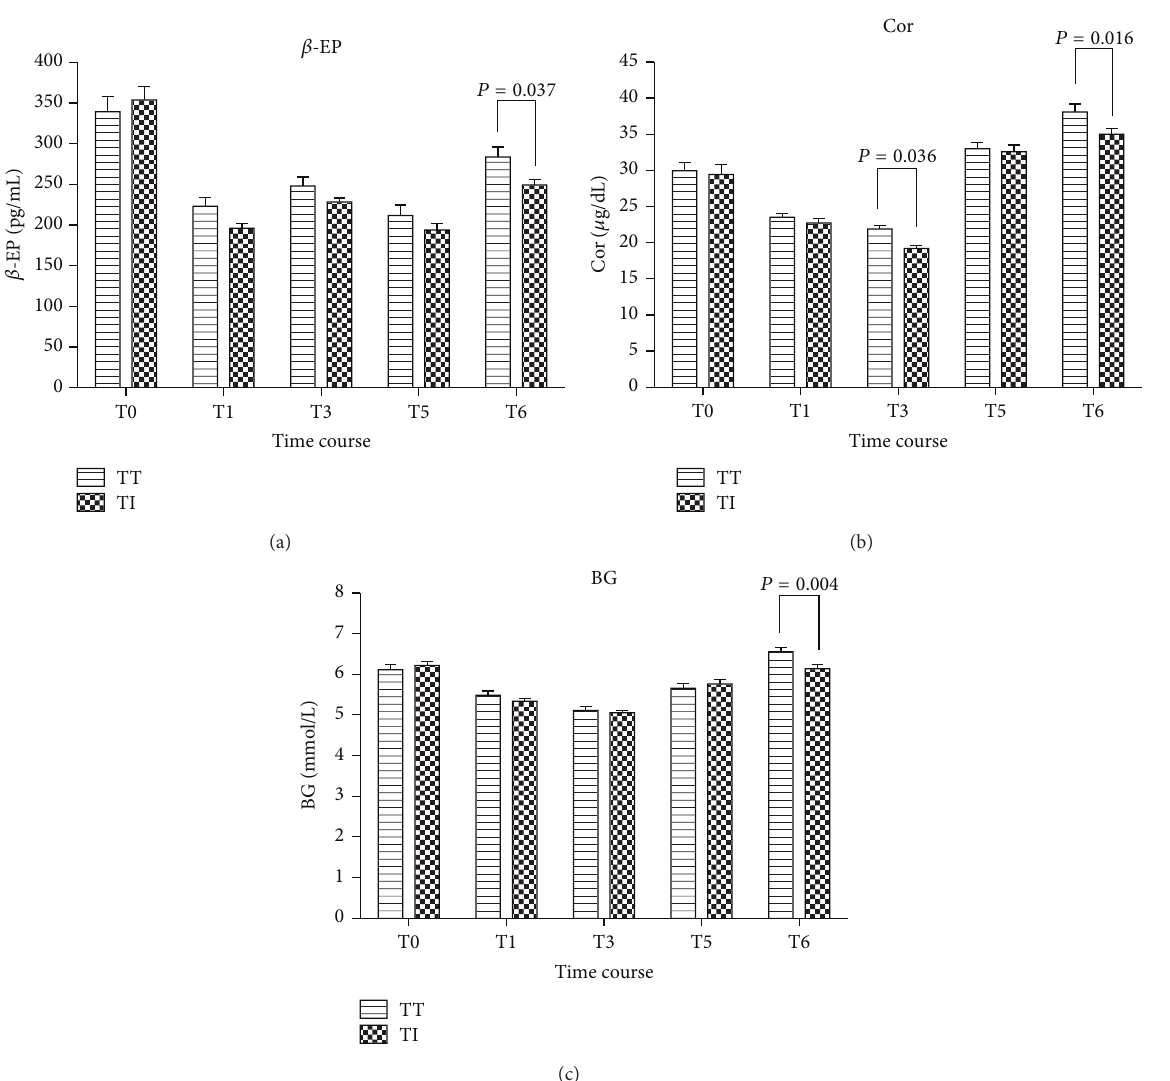
Figure 4: Changes in plasma 𝛽 -EP and Cor concentrations and BG in patients with a tracheal tube intubation (Group TT) or an I-gel facilitated endotracheal tube intubation (Group TI) during the study. Results are expressed as Mean ± SD. Mean concentration was lower during intraoperative period than at baseline in both groups ( 𝑃 < 0.0001 ). They began to rise during emergence, and the Cor concentration even higher than that of baseline (Group TT, 𝑃 < 0.0001 ; Group TI, 𝑃 = 0.0008 ). The percent increase tended to be higher in Group TT ( 𝑃 < 0.05 ). Baseline (T0); before anesthetic induction (T1); 3 min after intubation (T3); after patients entered the PACU (T5); and throughout emergence from anesthesia at 1 minute after extubation or I-gel removal (according to group assignment)